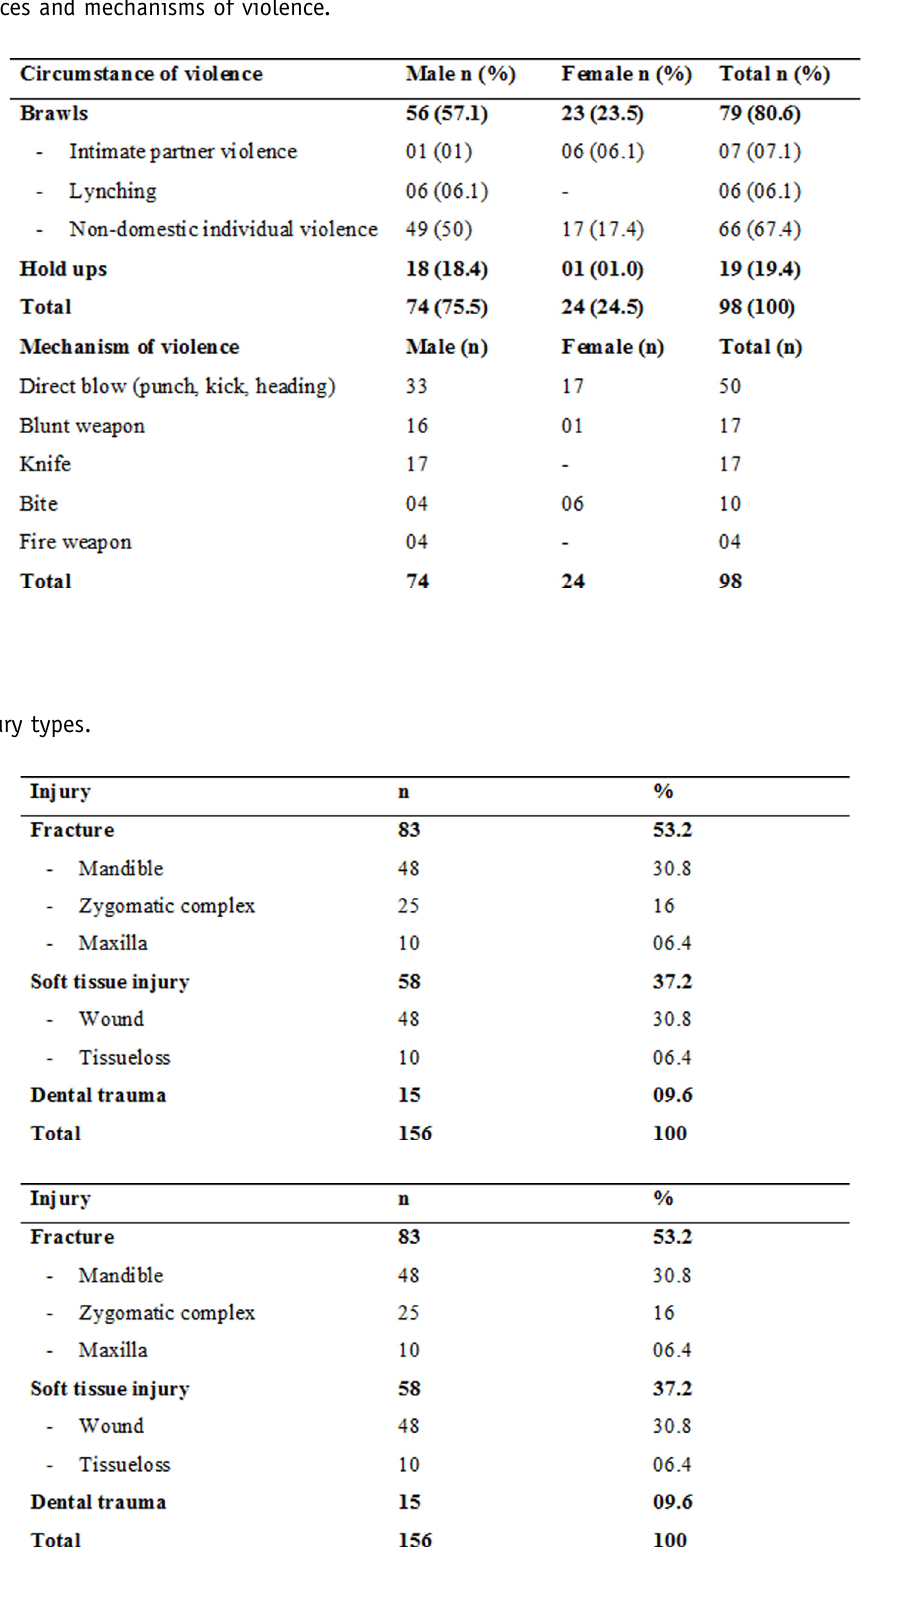
Table I. Circumstances and mechanisms of violence.